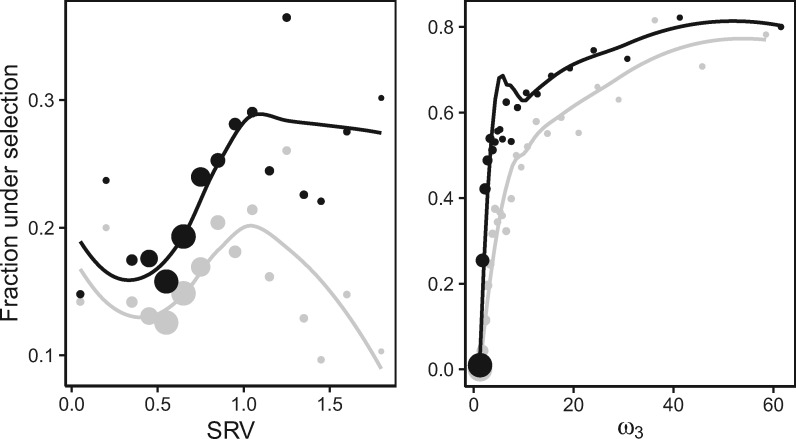
Fraction of Selectome alignments inferred to be under selection. Plotted points indicate the fraction of Selectome data sets inferred to have positive selection (P≤0.05). Each disc represents the average for at least 100 alignments with the size representing the relative number of alignments in each bin for BUSTED (black) and BUSTED[S] (gray). Smoothing curves are weighted Loess polynomials. SRV—coefficient of variation for synonymous rates, as inferred by BUSTED[S], ω3—the maximum likelihood estimate of ω3.